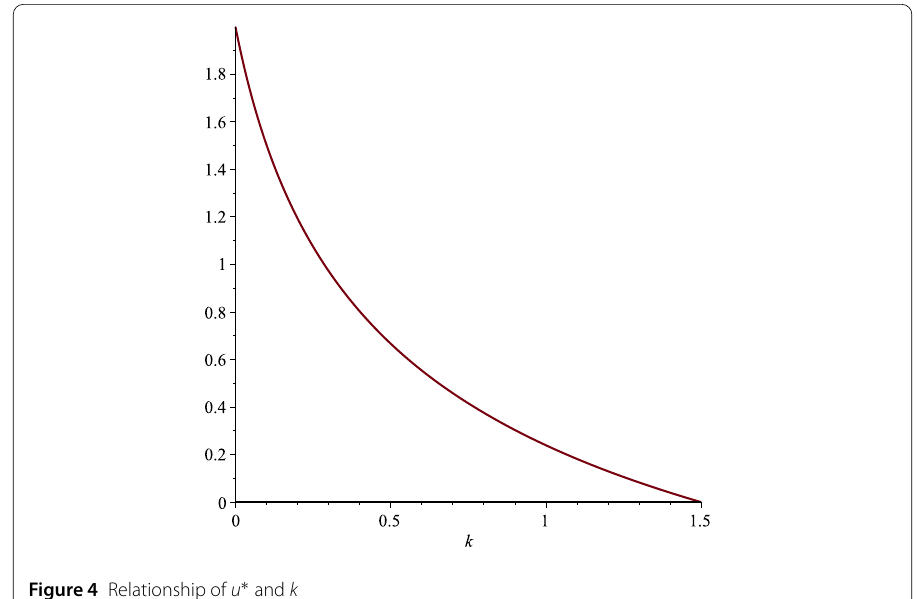
Figure 4 Relationship of u ∗ and